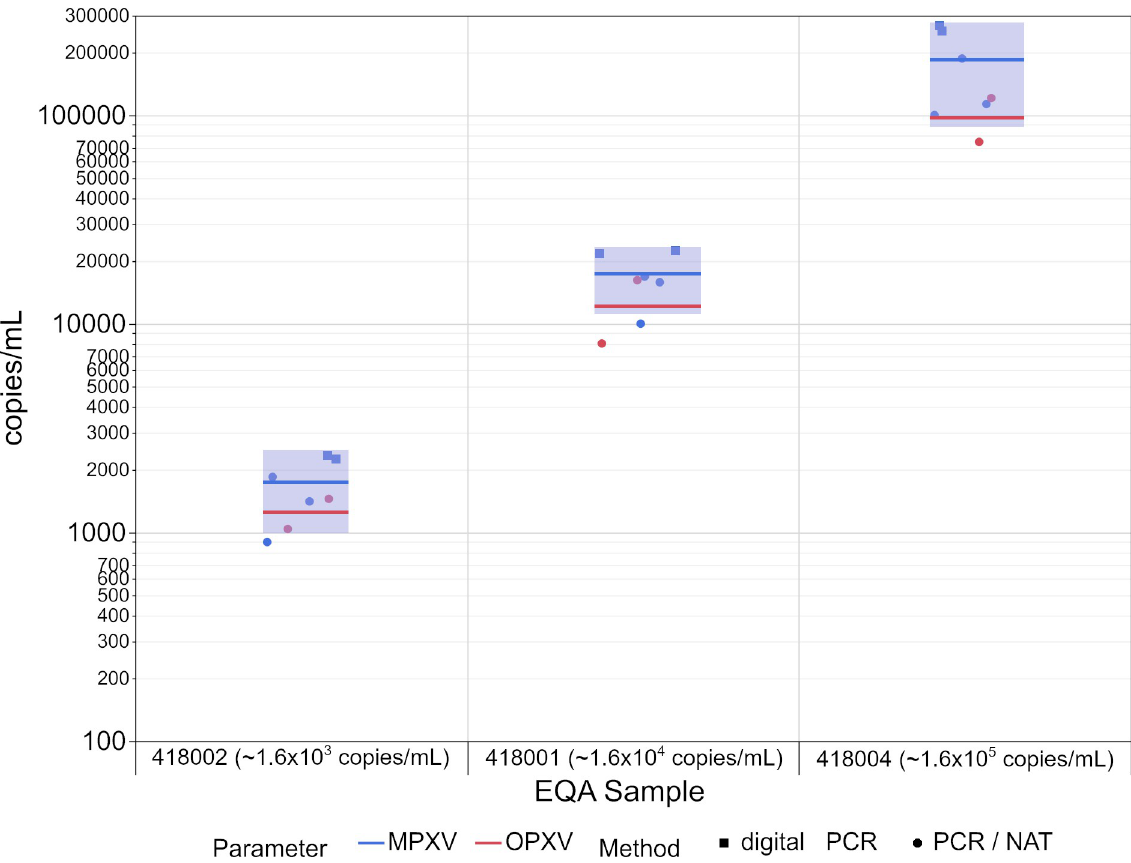
Fig 4. Distribution of the quantitative PCR results for monkeypox virus (blue) and orthopoxvirus (red) for the digital PCR (squares) and PCR/NAT (dots) methods. Seven participants reported results in copies/mL. The colored lines indicate the mean values of the quantitative results for MPXV (blue) and OPXV (red) respectively, and the blue area indicates the 95% confidence interval of the mean value for the quantitative MPXV PCR results. A confidence interval for OPXV was not